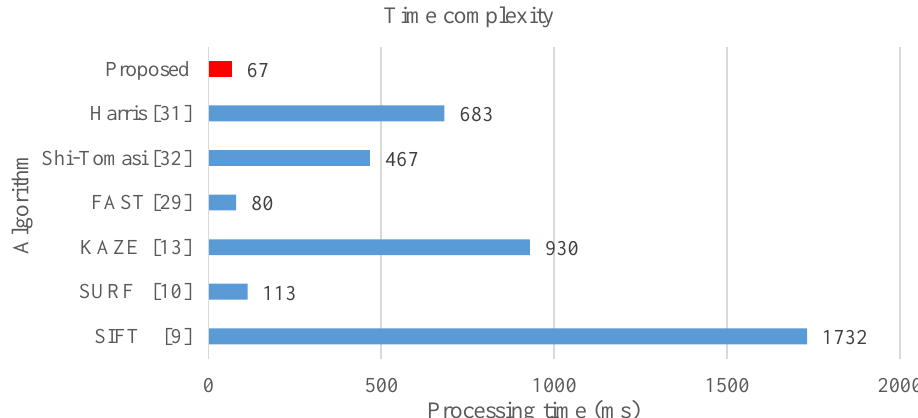
Figure 5. Performance comparison between MAGAST (proposed) and other feature detectors with relationship between the three of scales and processing time. The images are of size 800 × 600 and approximately 1000 keypoints are detected.